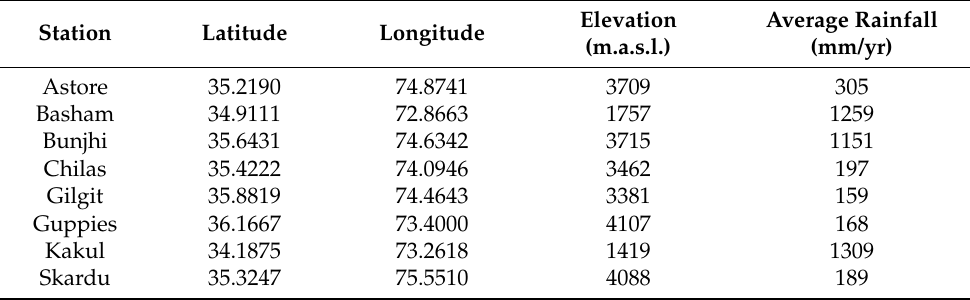
Table 1. Meteorological stations, their locations, and their elevations.